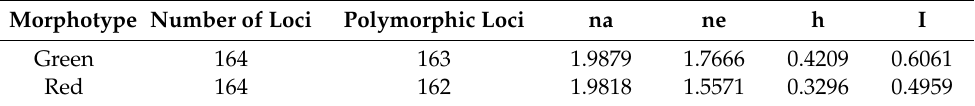
Table 3. Genetic diversity of two ecotypes. Morphotype Number of Loci Polymorphic